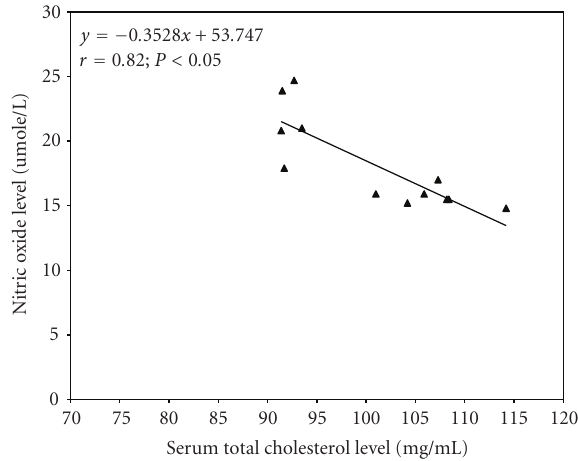
Figure 3: Regression analysis showing the relationship between serum total cholesterol and nitric oxide levels in LMMe-fraction treated mice for 21 days. Every 1mg/dL decrease in serum total cholesterol was associated with 0.35 umole increase in NO.